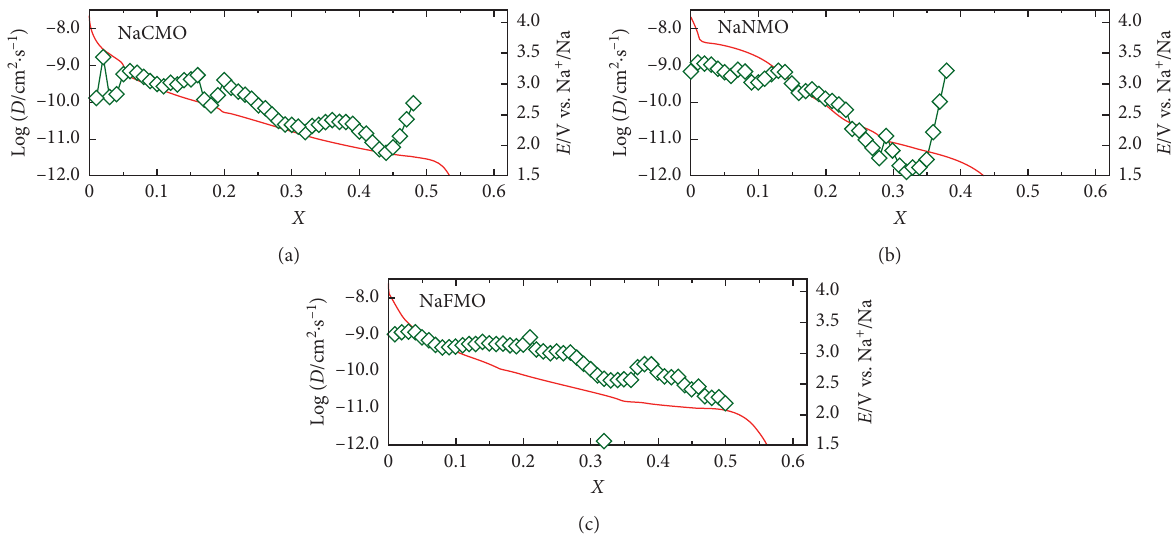
Figure 7: Evolution of sodium diffusion coefficient D Na into NaCMO (a), NaNMO (b), and NaFMO (c) hosts in the first discharge.